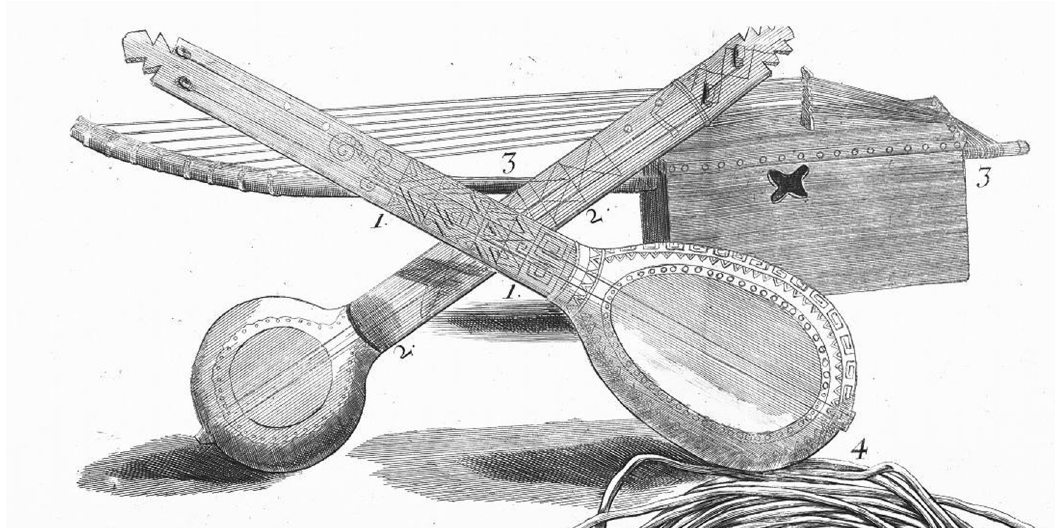
Fig. 2 Two early gourd banjos, labeled “ strum strumps, ” collected in Jamaica by Hans Sloan (Sloane, 1707). Strum strumps in the foreground, illustrated with a harp and fi bers used to produce lute strings.